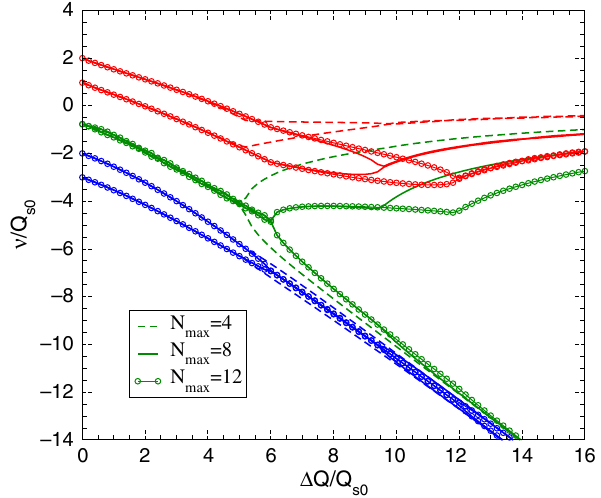
FIG. 3. The threshold bunch spectrum obtained with different N . Only essential (capable to coalesce) spectral lines are max